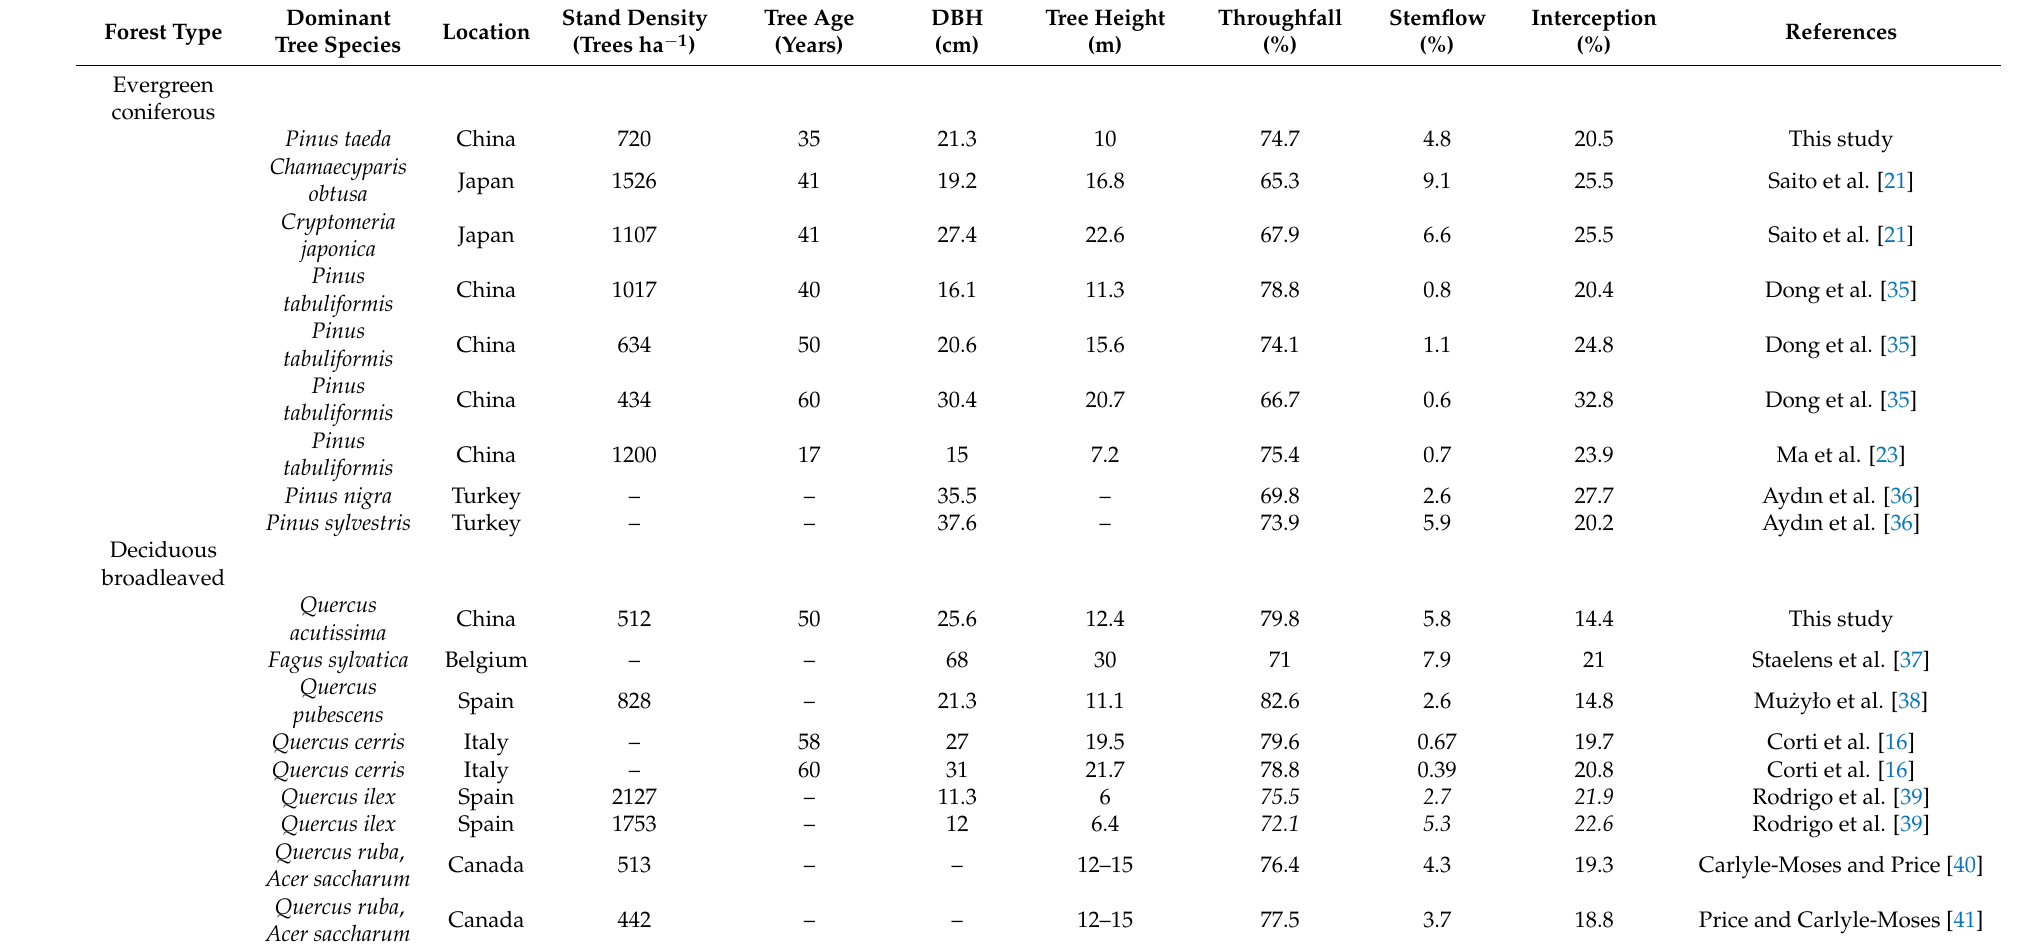
Table 3. Rainfall physical partitioning characteristics of evergreen coniferous forest stands, and deciduous broadleaved forest stands in different